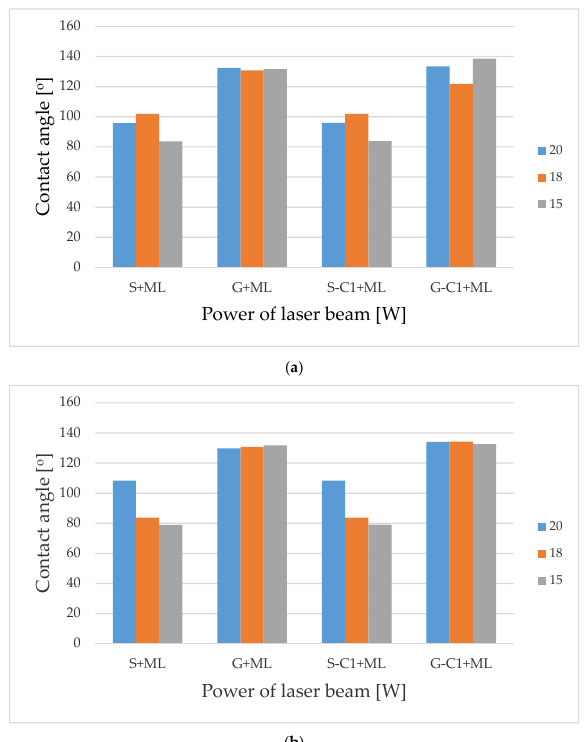
Figure 12. Contact angle dependence on the laser beam power function for samples after laser texturing for ( a ) t = 220 ns, v = 300 mm/s, f = 35 kHz, h = 100 µm, ( b ) t = 120 ns, v = 470 mm/s, f = 55 kHz, h = 50 µm.